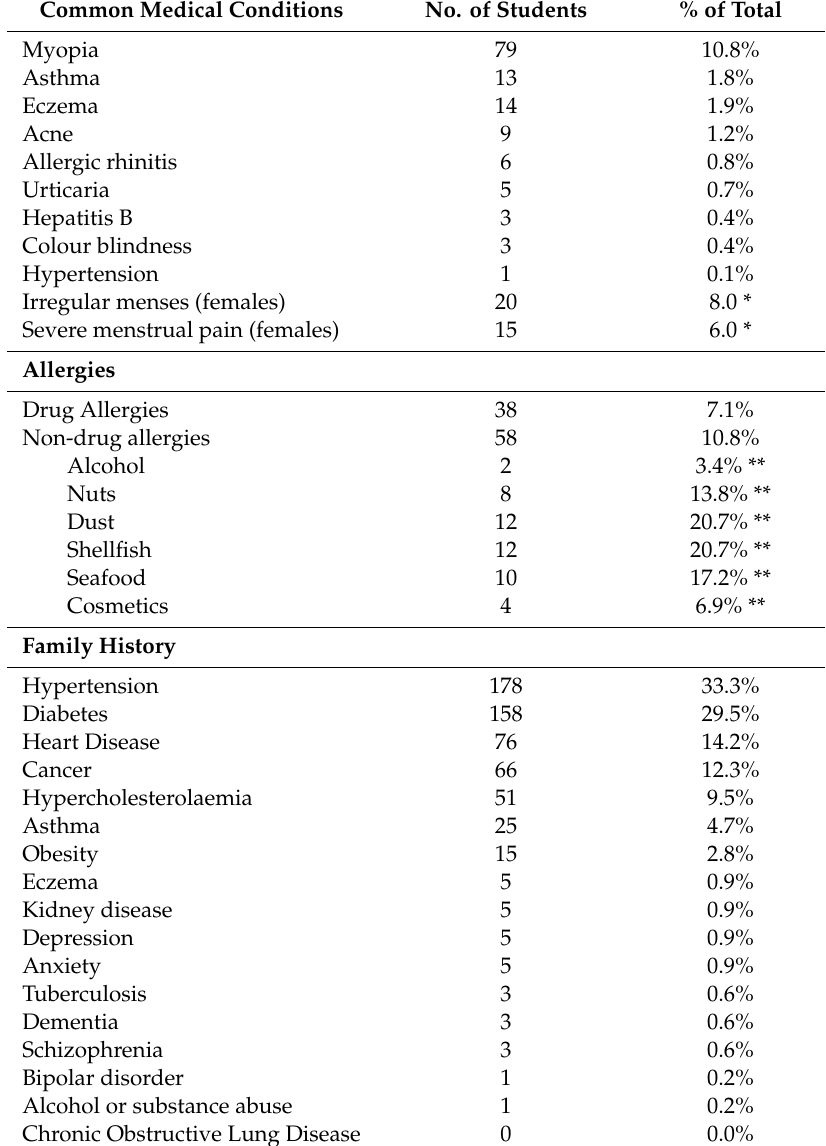
Table 3. Overview of common student medical conditions, allergies, and family history of disease. Common Medical Conditions No. of Students % of Total